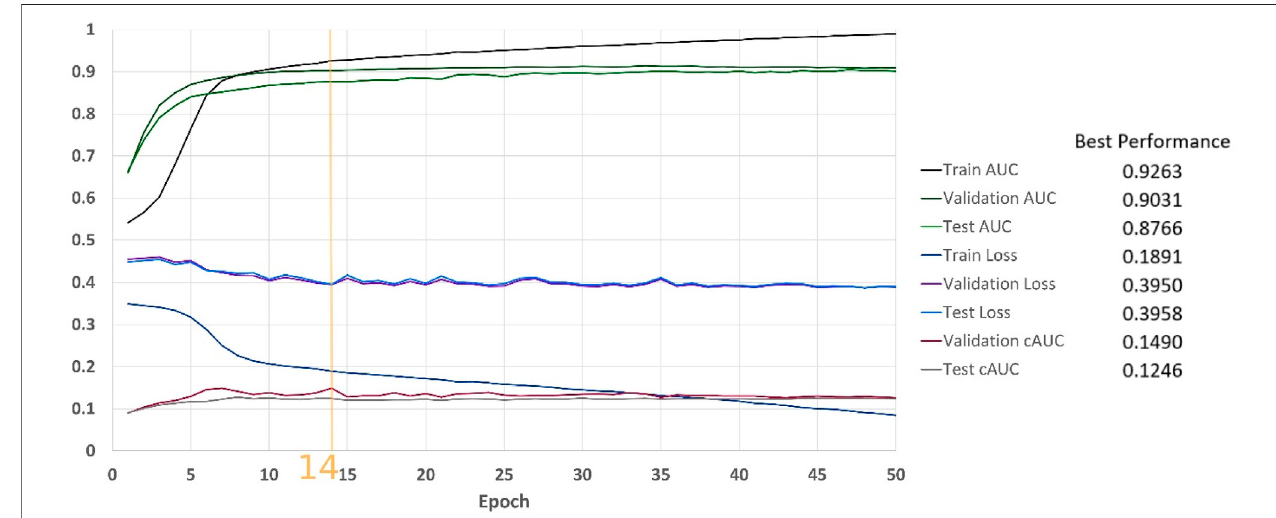
FIGURE 8 | Classi fi cation results on the MINIST-based dataset.